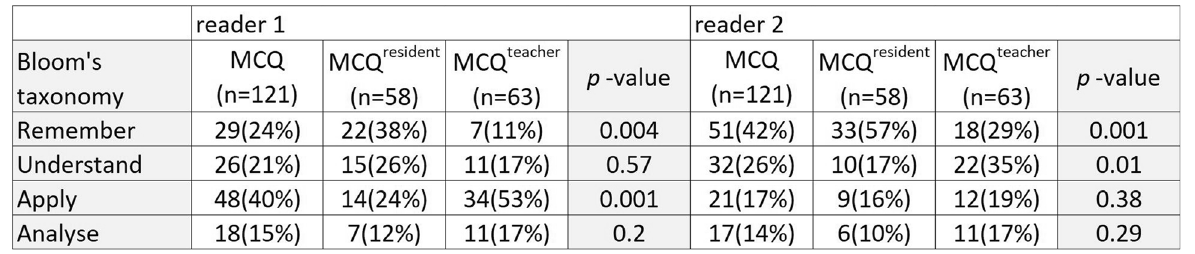
Table 3 Comparative Bloom ’ s taxonomy analysis by two readers for MCQ resident and MCQ teacher . The p value < 0.05 was considered to indicate statistically significant